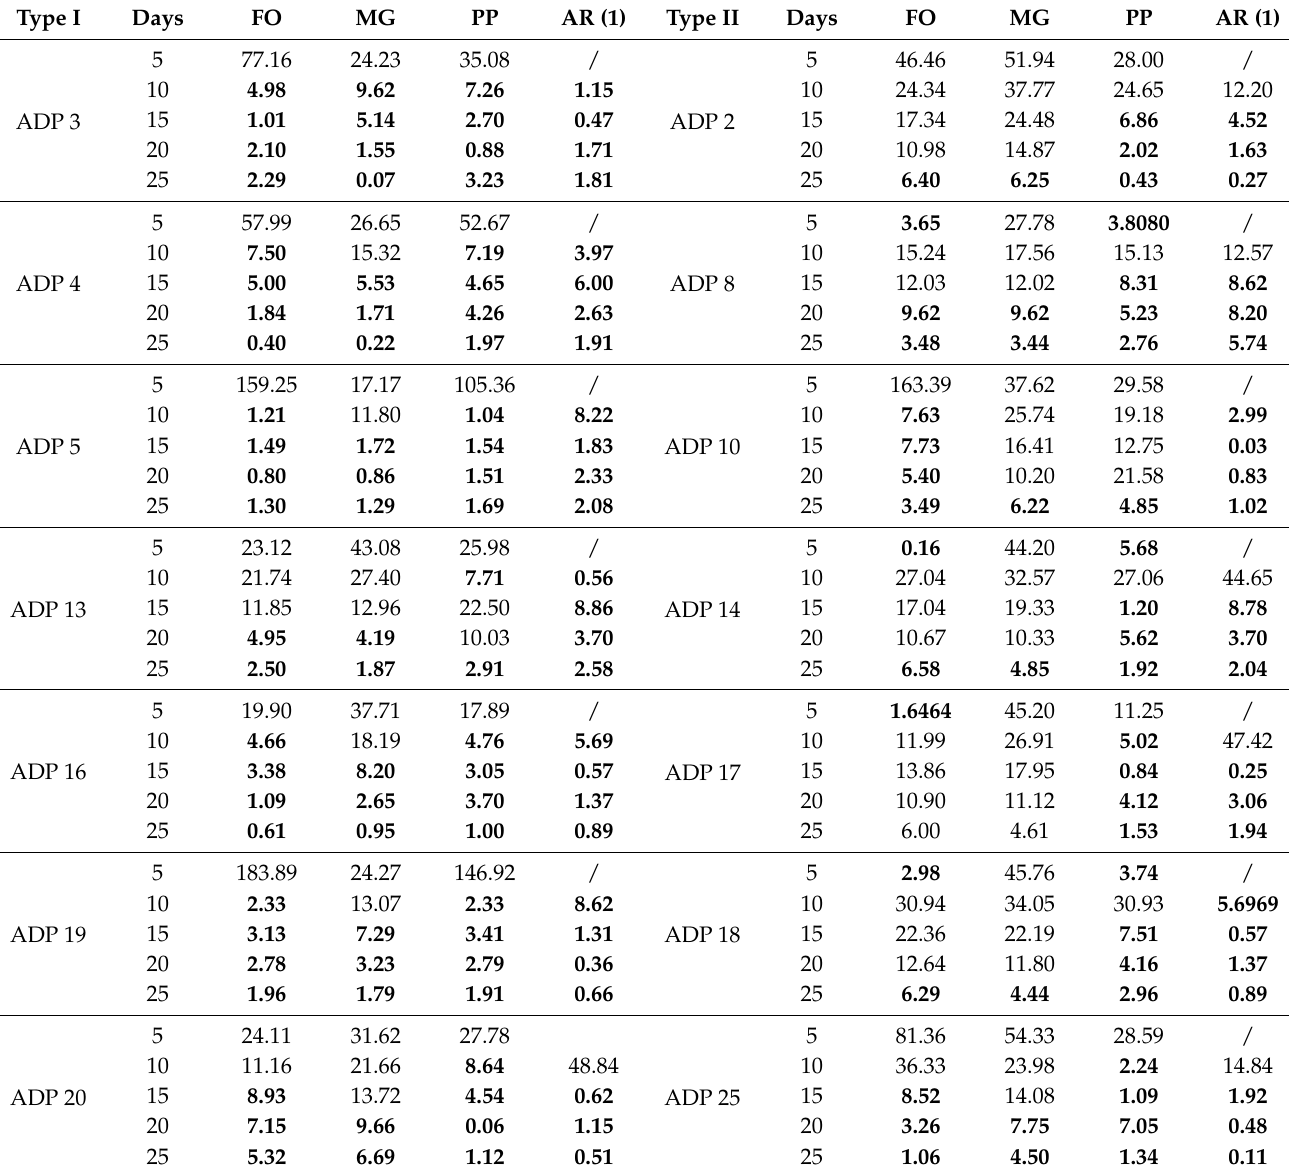
Table 6. The level of accuracy (expressed in APE%) of predicted 28-day RBP test result from fitting the mathematical models to an increasing number of experimental observations from 5 days to 25 days. APE less than 10% indicates accurate predication (in